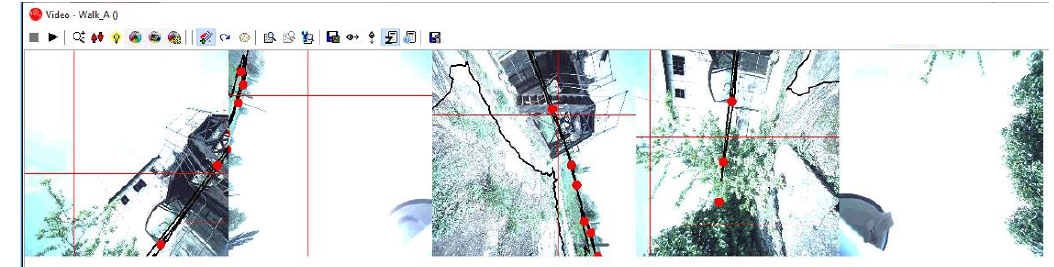
Figure 23. Video images of Sânmihaiu Romanian Lock.